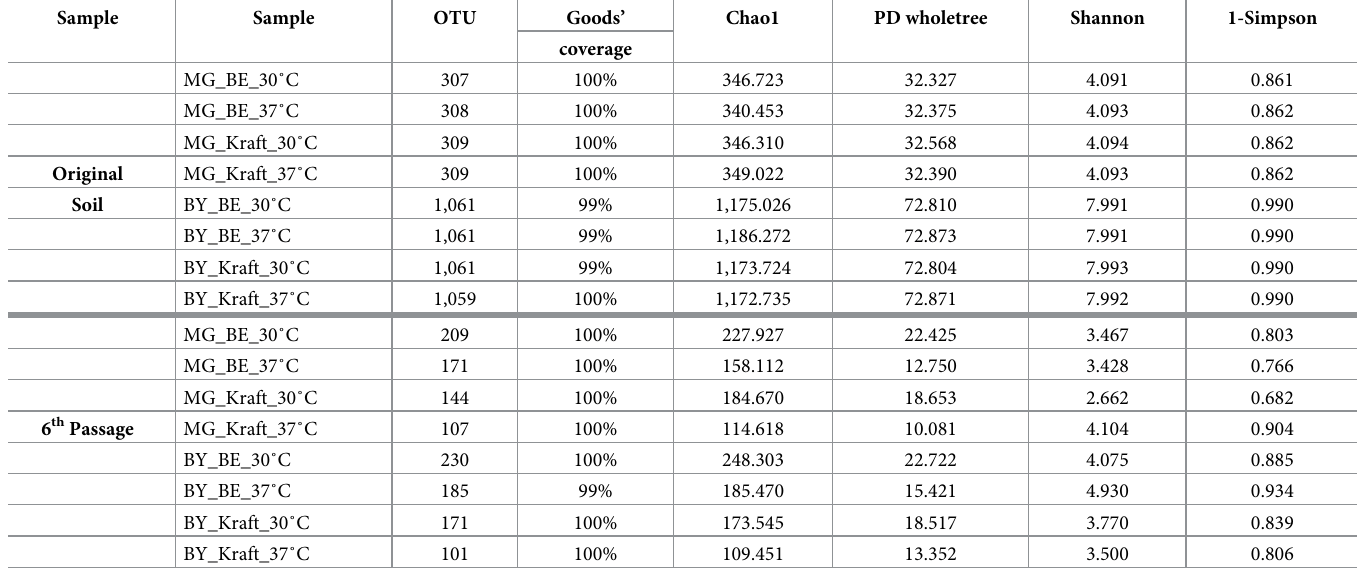
Table 1. Diversity indexes for the original substrate (i.e., MG and BY compost soils) and at the sixth passage of enriched bacterial consortia, for base-extracted and Kraft lignin utilization cultivated at 30˚C and 37˚C. Sample